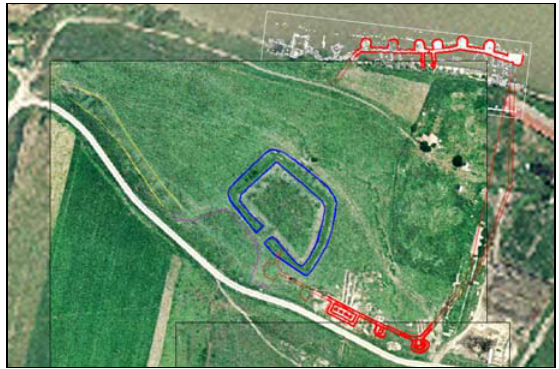
Figure 3. Northern section researched in the 1970s (north, bold red) and southern section researched from 1990s onwards (south, bold red); presumed locations for eastern and western curtains of the eastern fort (thin, red); double precinct for the western fort (yellow); Middle Age Turkish fort (blue). Drawings overlaped on ortophotoplan.